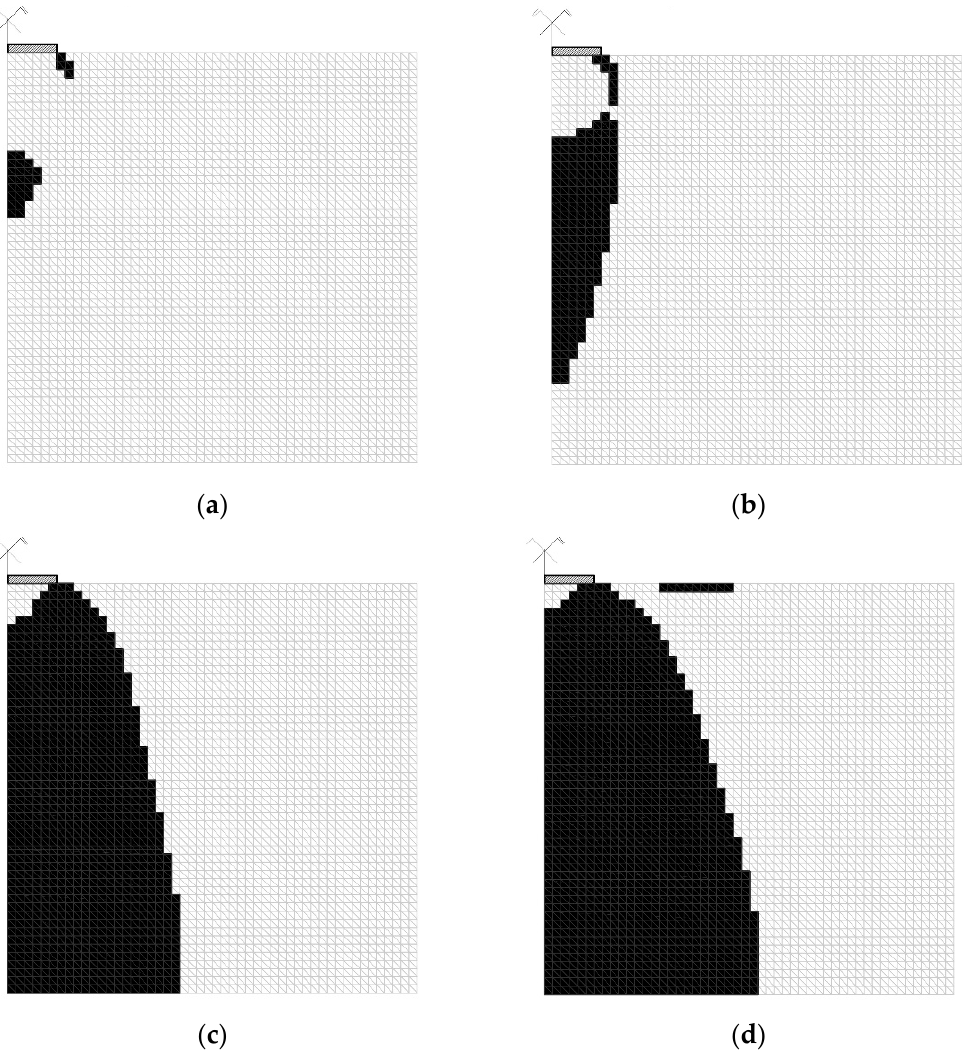
Figure 11. Spread of yielded zone series MB30. ( a ) Vertical displacement v = 0.015 mm. ( b ) Vertical displacement v = 0.017 mm. ( c ) Vertical displacement v = 0.036 mm. ( d ) Vertical displacement v = 0.040 mm.